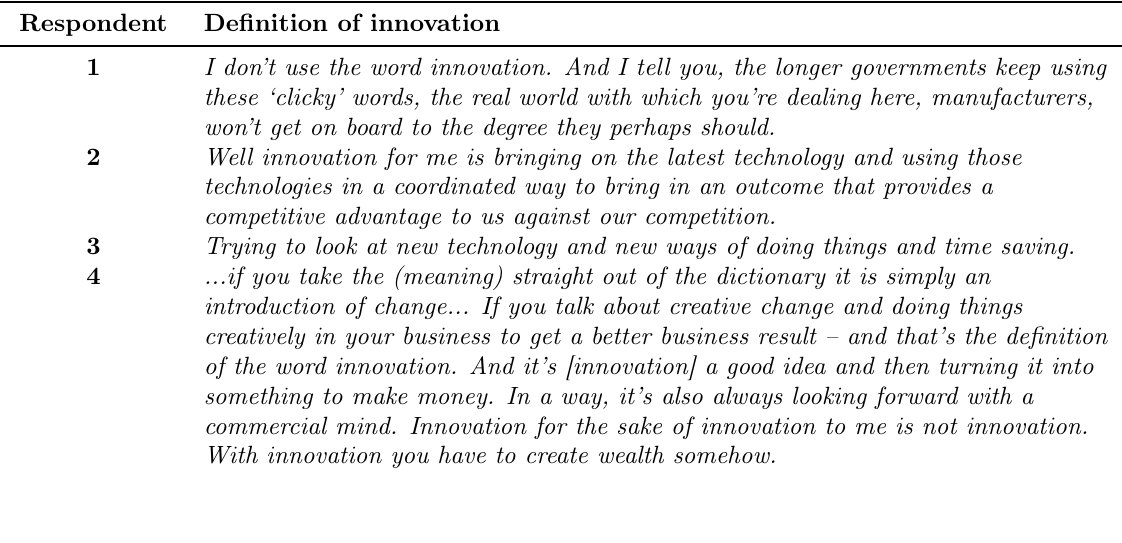
Table 3 . Definitions of innovation from Advanced Manufacturing Firms